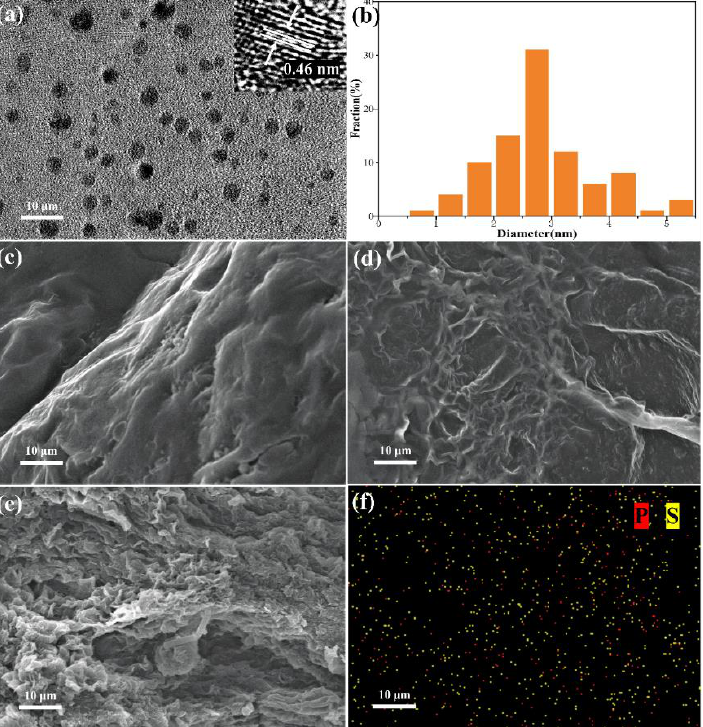
Figure 1. ( a ) TEM image of P-SQDs, the inset is a HRTEM image of P-SQDs showing the lattice spacing, ( b ) particle size distribution of P-SQDs. SEM images of ( c ) g-C 3 N 4 and ( d , e ) P-SQDs/g-C 3 N 4 , ( f ) the EDS elemental map image of P-SQDs/g-C 3 N 4 .